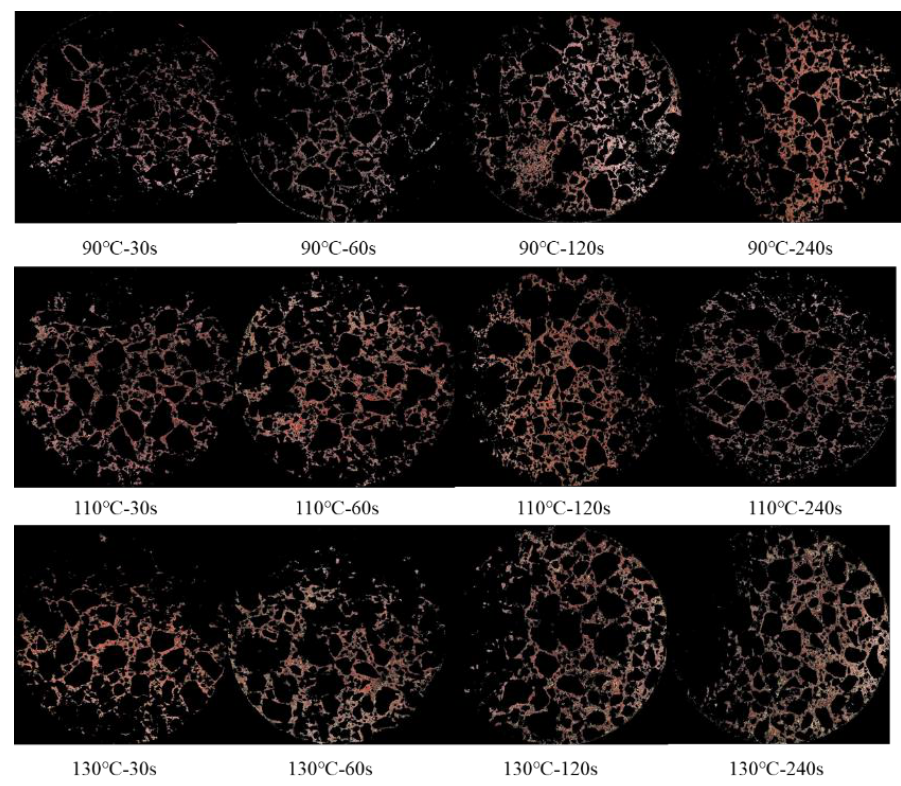
Figure 12. Visualization of RAP binder distribution at different mixing conditions.